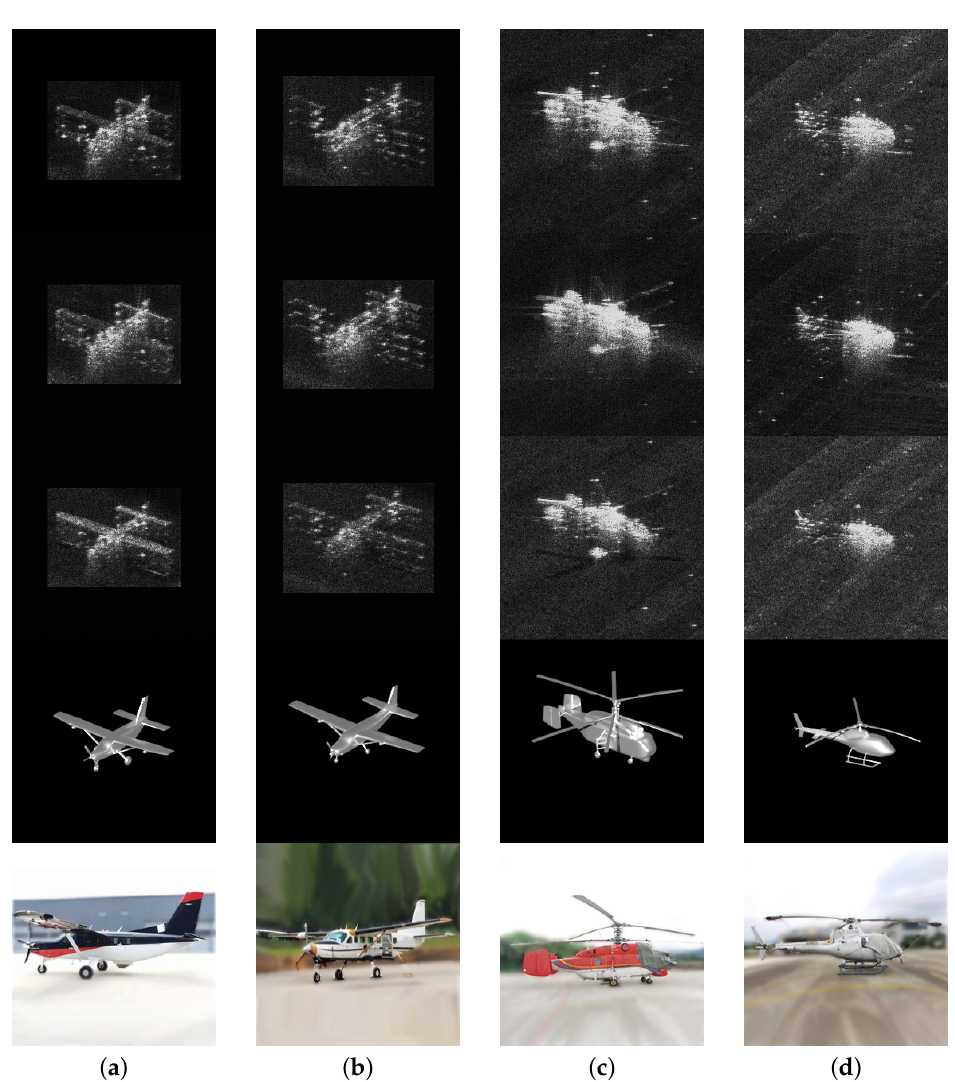
Figure 4. Examples of SPH4 and photos of the targets. Columns ( a – d ) show one of the categories of Quest Kodiak 100 Series II, Cessna 208B, Ka-32, and AS350, respectively. Images of each row from top to bottom belong to SAR images in HH, SAR images in HV, SAR images in VV, optical images, and photos of the targets,